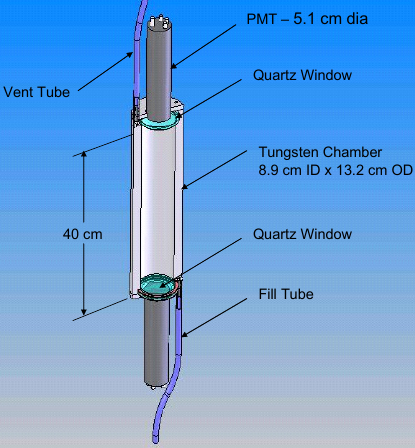
Figure 7. Schematic of the 90 Sr final design which includes a passive tungsten shield and two 5.1-cm diameter